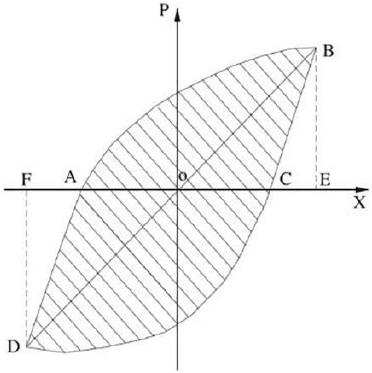
Figure 24. Area chart of energy consumption capacity. Table 5. Equivalent viscous damping coefficient. Loading